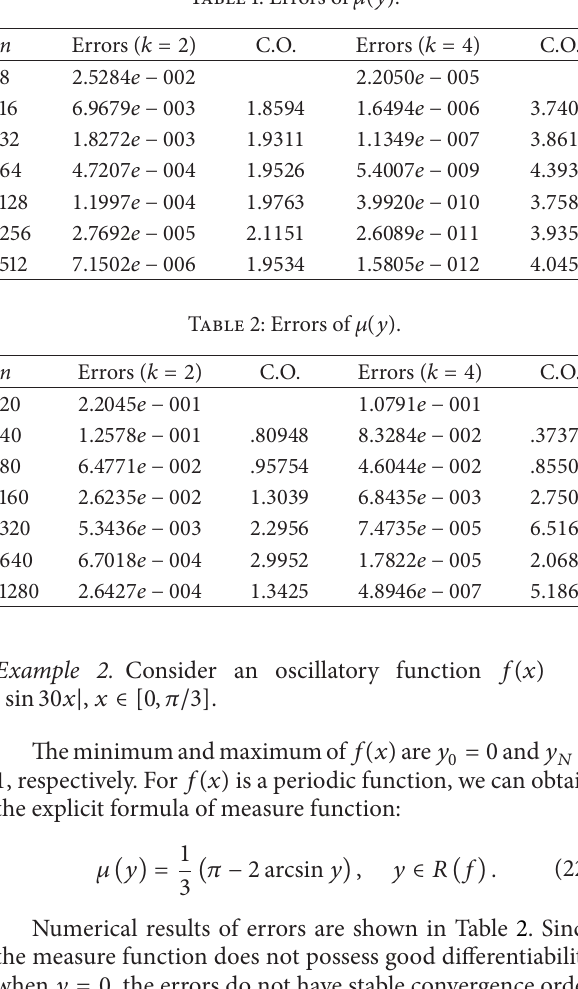
Table 1: Errors of 𝜇(𝑦) .